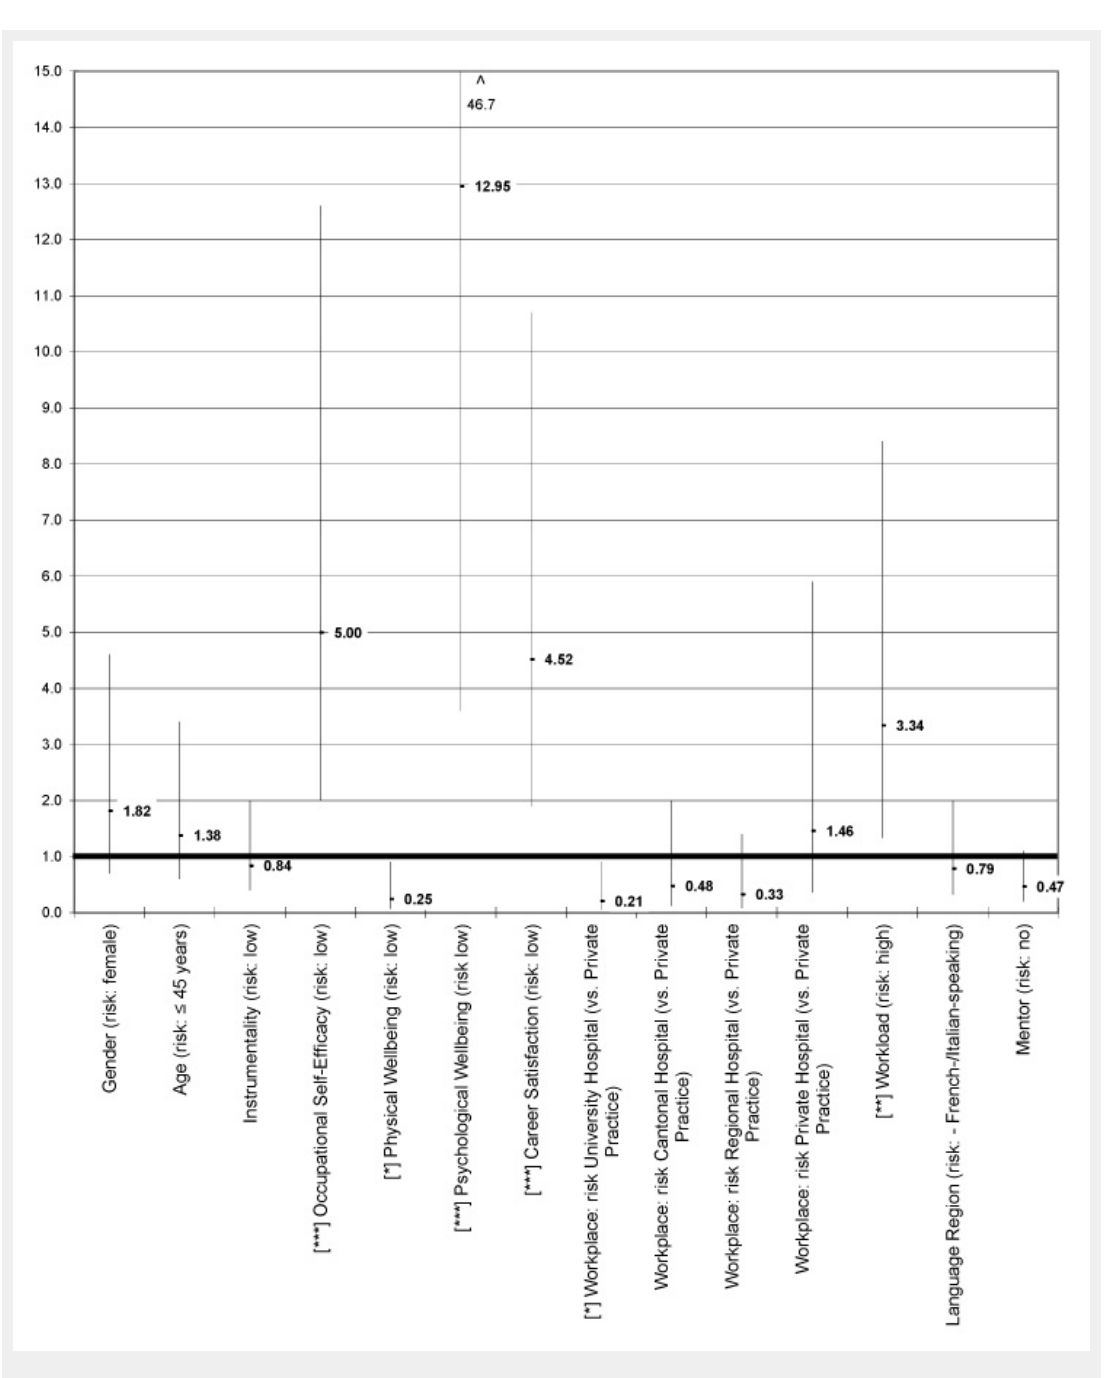
Figure 2 Logistic regression analysis of determinants of radiologists’ professional satisfaction. Legend: Level of significance: *** p <0.001; ** p <0.01; * p <0.05 (Wald statistics). ^ The upper value of the confidence interval being 46.7 has been cut